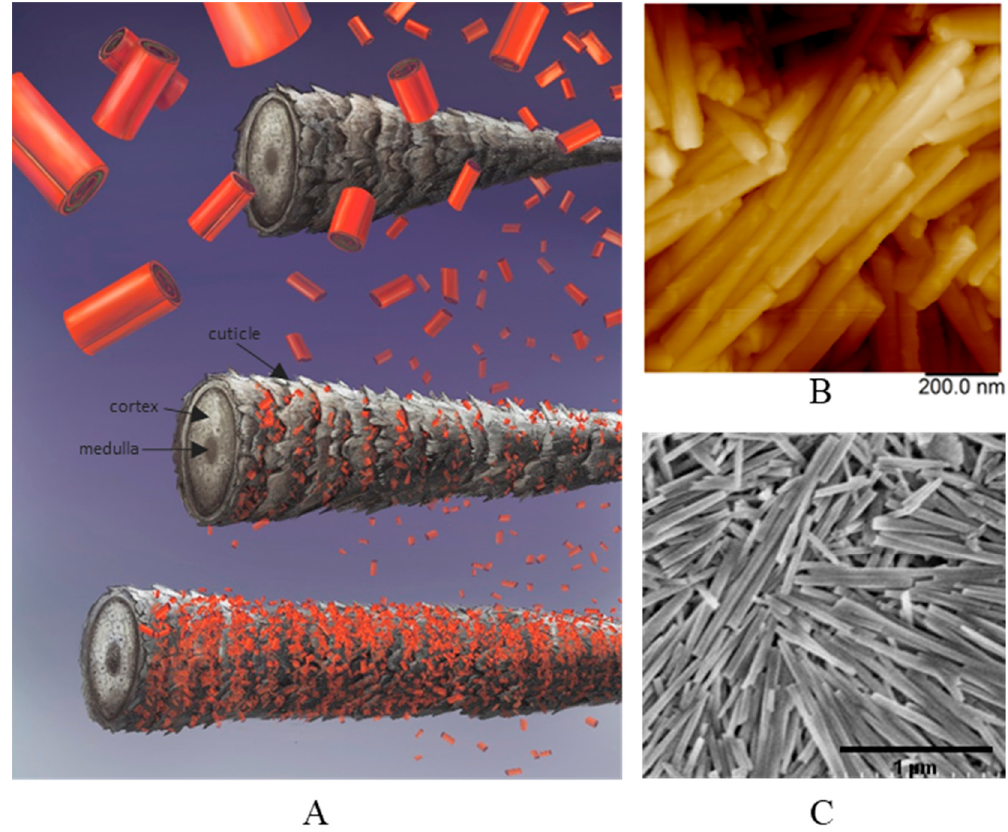
Figure 1. Introduction to the self-assembly of halloysite nanotubes on hair and development of the coating from anchoring in the cuticle to capillary force / drying driven surface assembly ( A ), and atomic force microscopic and scanning electron microscopic (AFM, SEM) images of dried clay nanotubes ( B , C ). Reproduced from Ref. [23] with permission from the Royal Society of Chemistry.